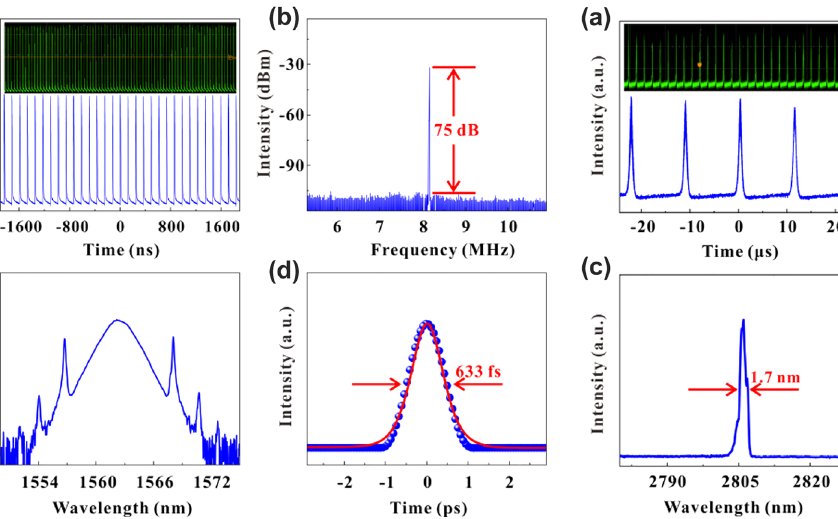
Figure 7: Experimental results of a 1.5 µm mode-locked fi ber laser. (a) The pulse sequence displayed on the oscilloscope. (b) The RF spectrum. (c) Spectral diagram. (d) Single-pulse diagram.